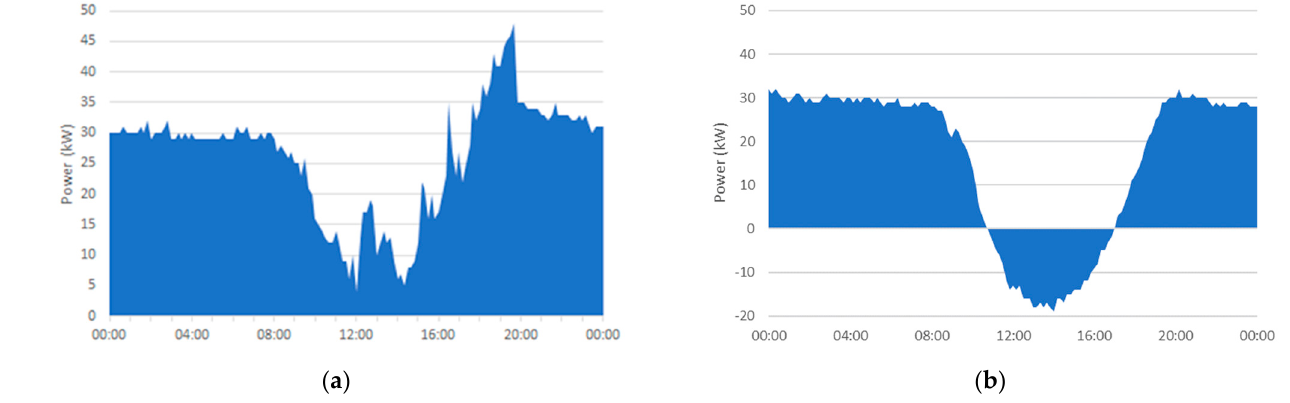
Figure 8. Twenty-Four-Hour Typical net Load Diagrams: ( a ) Weekday; ( b ) Weekend.